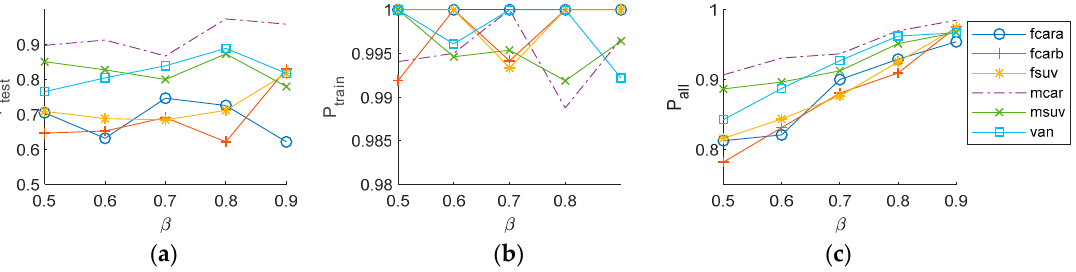
Figure 8. The curve of overall accuracy changing with the training images ratio β at different image size. ( a ) The accuracy of the test set; ( b ) The accuracy of the training set; and, ( c ) The accuracy of all images.